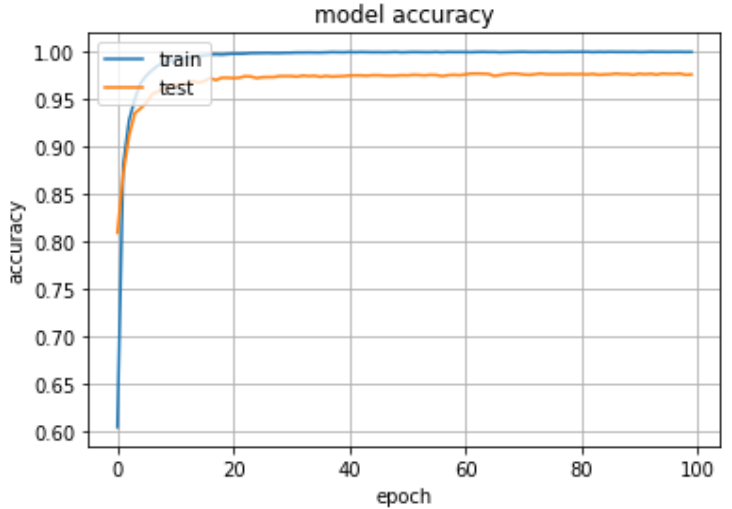
Figure 11. Ground object classification accuracy versus the number of iterations for a hierarchical fusion residual network with a sample size of 25 × 25 and a network depth of 32.